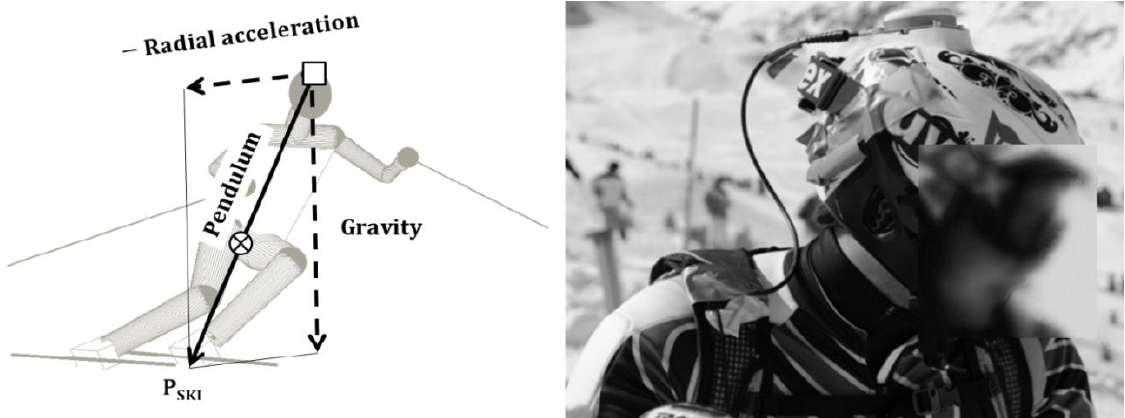
Figure 2. Left side: The pendulum model approximating the CoM in the dGNSS model. CoM position ( ), antenna position (  ). Right side: Skier with GNSS antenna mounted on the